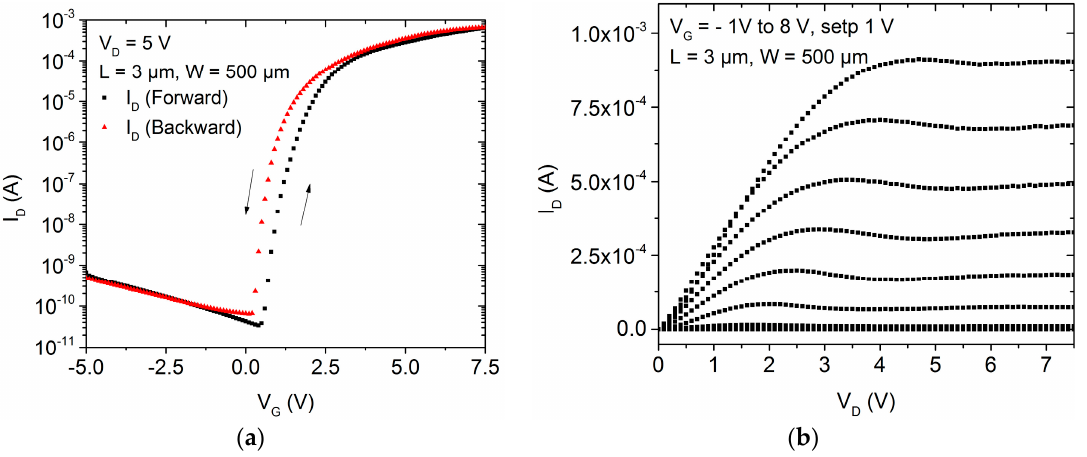
Figure 5. ( a ) Transfer and ( b ) output characteristics of a ZnO nanoparticle TFT applying an inverted staggered setup.